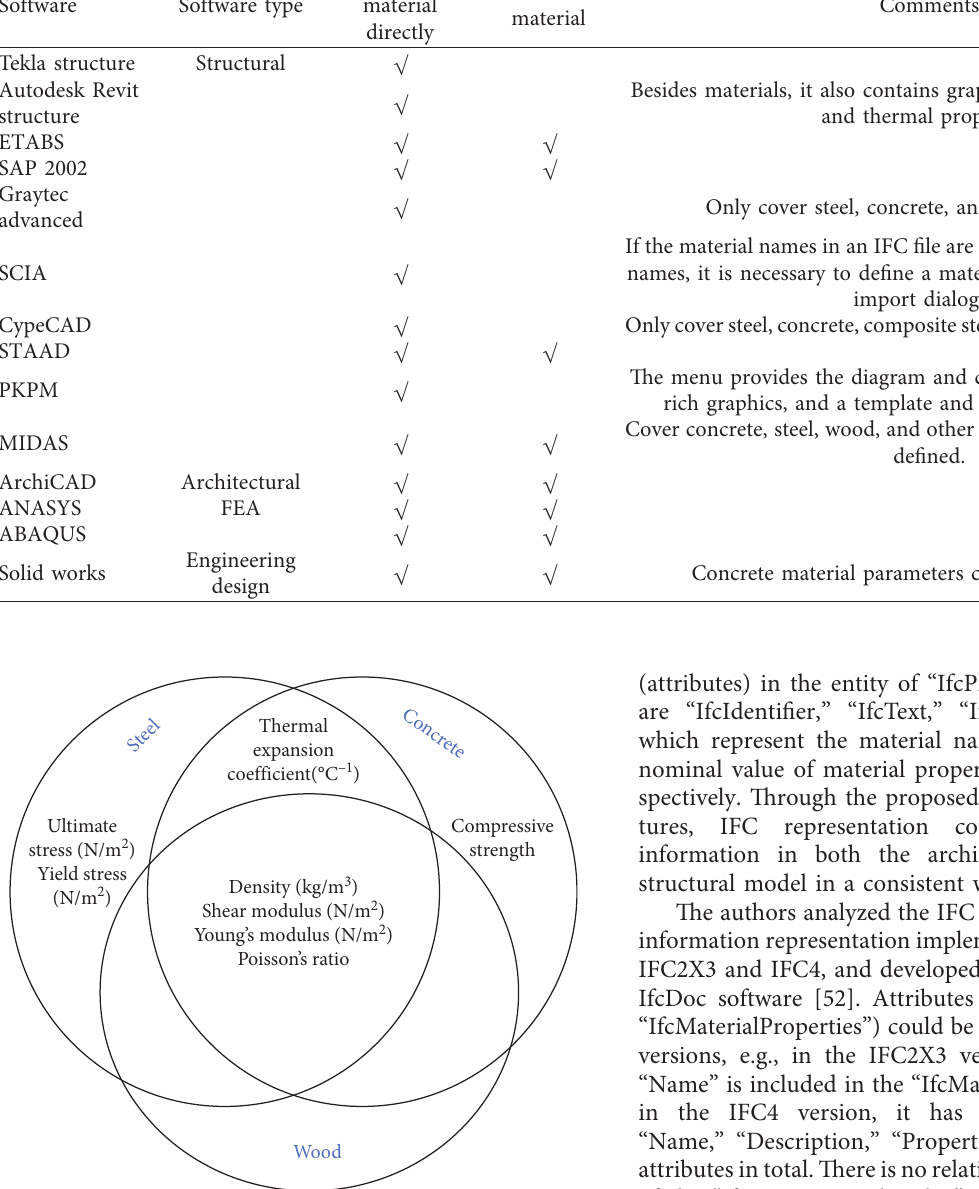
Figure 3: Material signature for different material